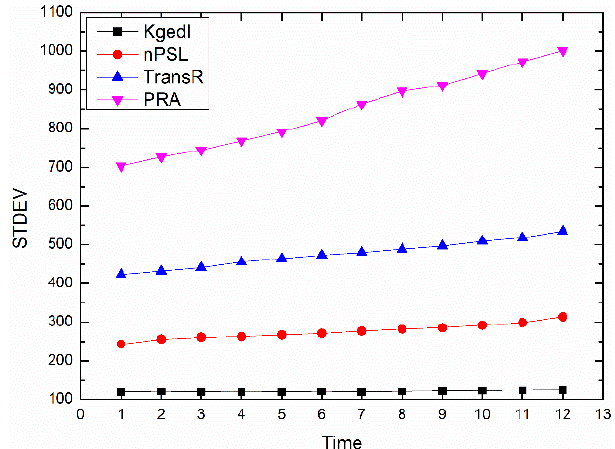
Figure 6. The link prediction comparison of STandard DEViation (STDEV) of MAR between Kgedl and baseline methods on the YAGO dataset.